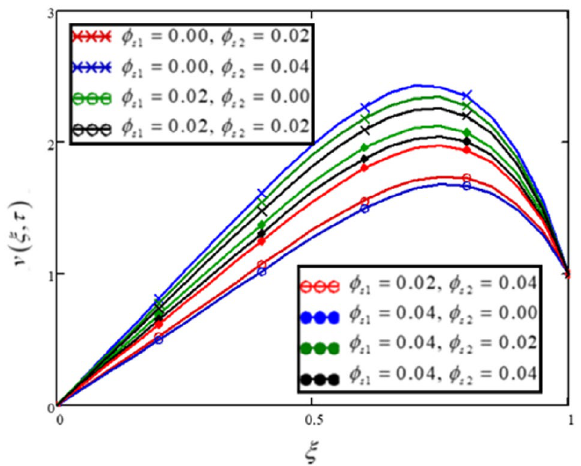
Figure 6. The effect of volume fractions of clay nanoparticles and alumina Al 2 O 3 on the flow profile.